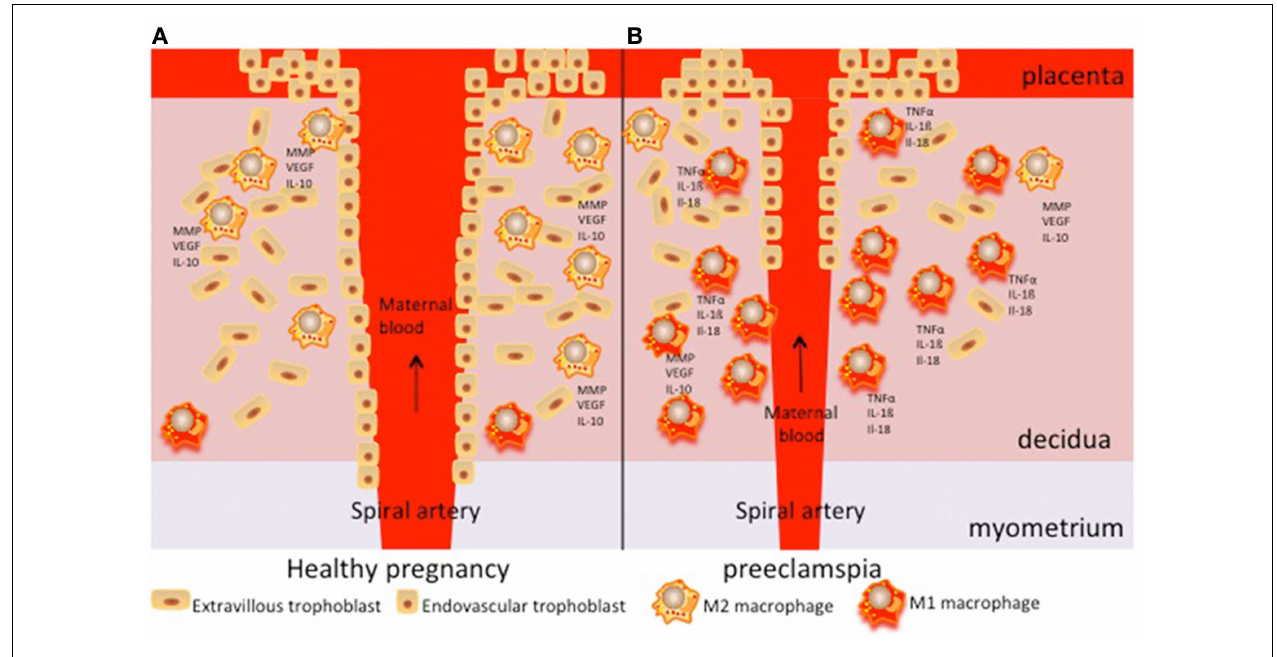
and tissue remodeling (such as MMP andVEGF).They also play a role in immunomodulation, for instance by producing IL-10. During pre-eclampsia, increased numbers of M1-like macrophages are found.They may produce pro-inflammatory cytokines, such asTNF α , IL-1 β , or